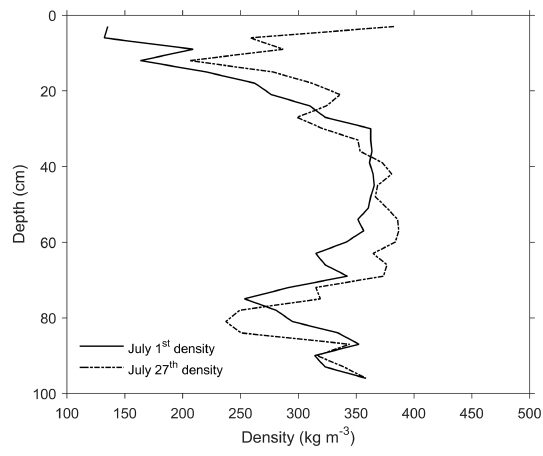
Figure 10. Density profiles in the snow pits sampled at Summit in 1 and 27 July 2012. The depth scale of the snow pit sample in 27 July was adjusted to find a reasonable match with the density profile of the snow pit sampled in 1 July.